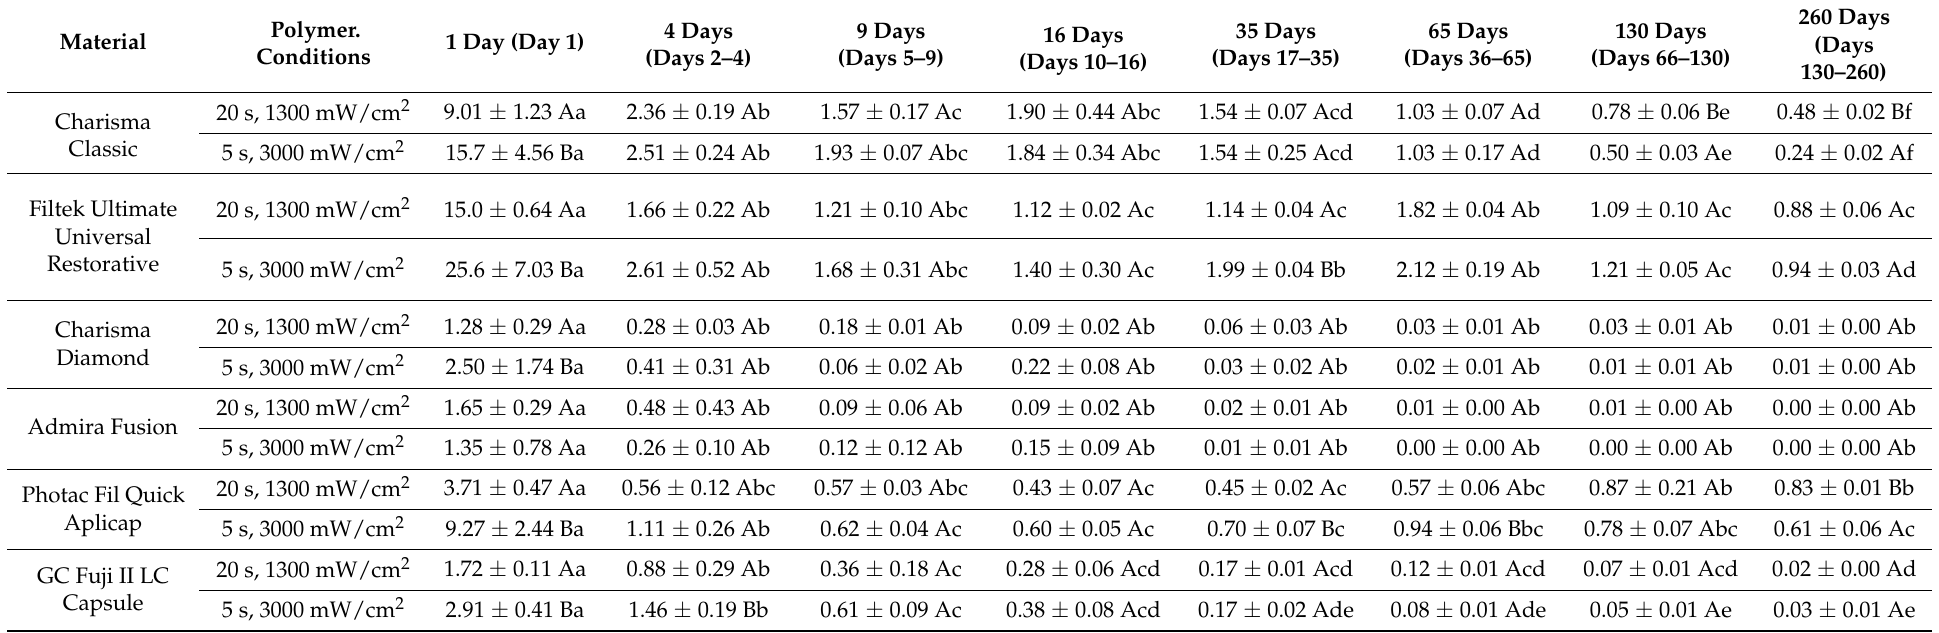
Table 3. Average daily release of BPA in methanol per gram of material (mean ± SD in